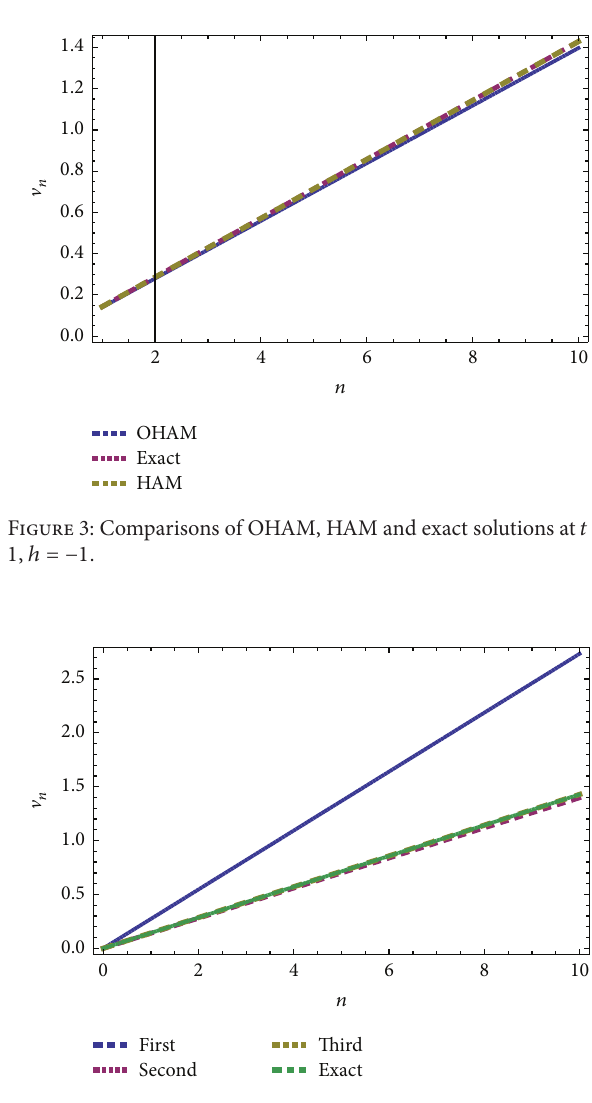
Figure 4: Comparison of first, second, third of OHAM, HAM and exact solutions at 𝑡 = 1 , ℎ = −1 .